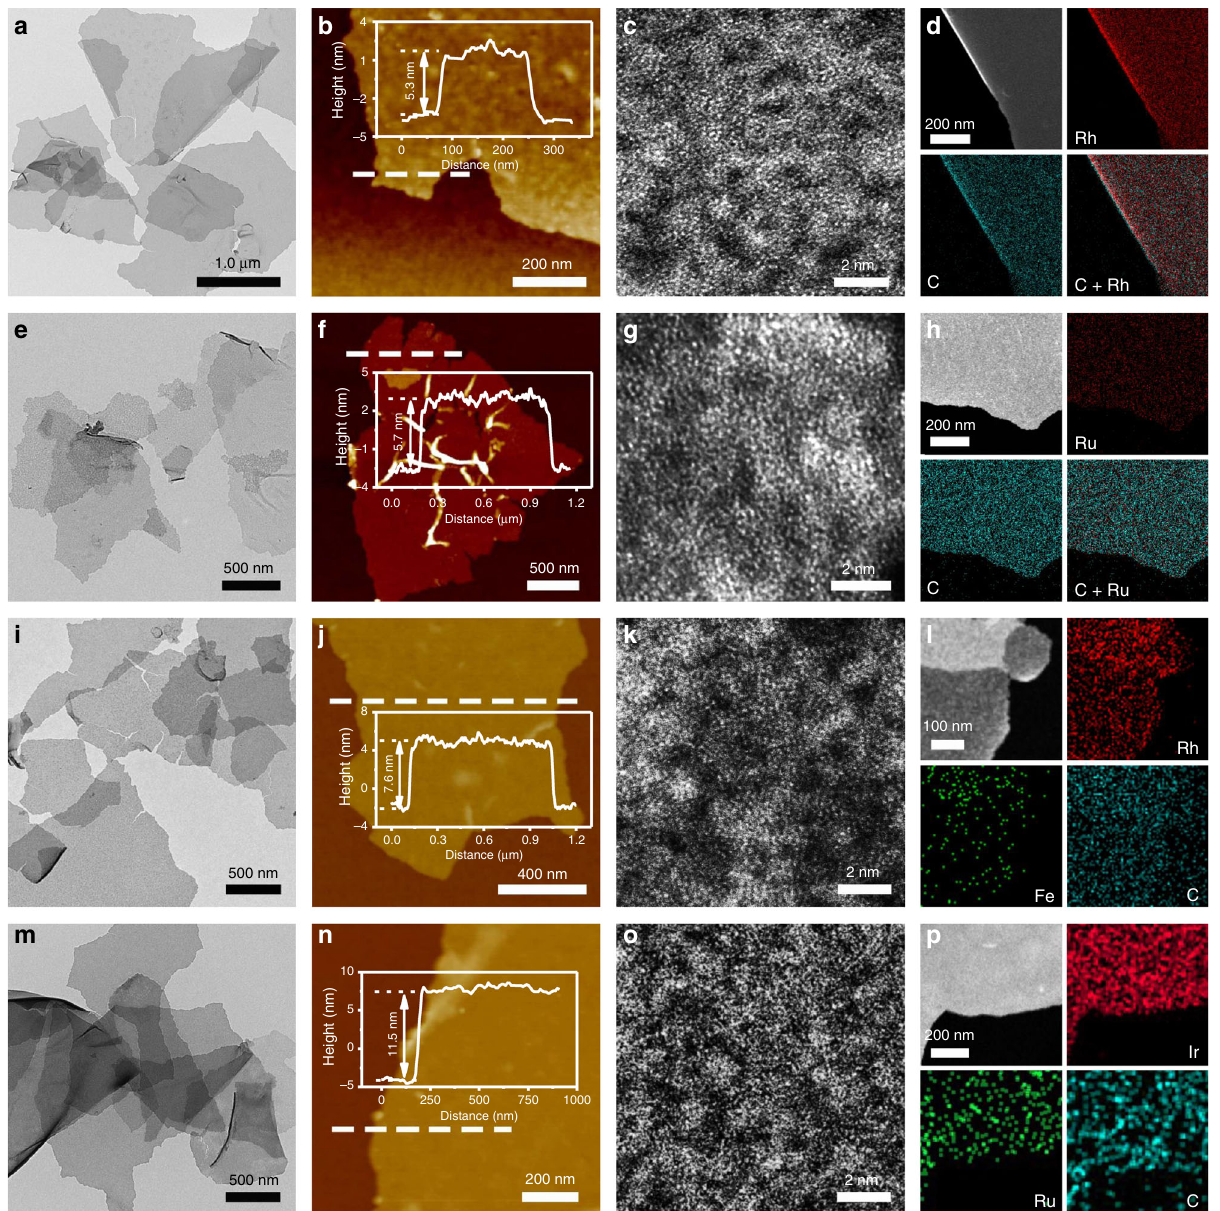
Fig. 3 Characterizations of other amorphous noble metal NSs. a , e , i , m TEM, b , f , j , n AFM, c , g , k , o aberration-corrected HAADF-STEM image, and d , h , l , p HAADF-STEM image and the corresponding EDS elemental mapping of amorphous Rh NSs, Ru NSs, RhFe NSs, and IrRu